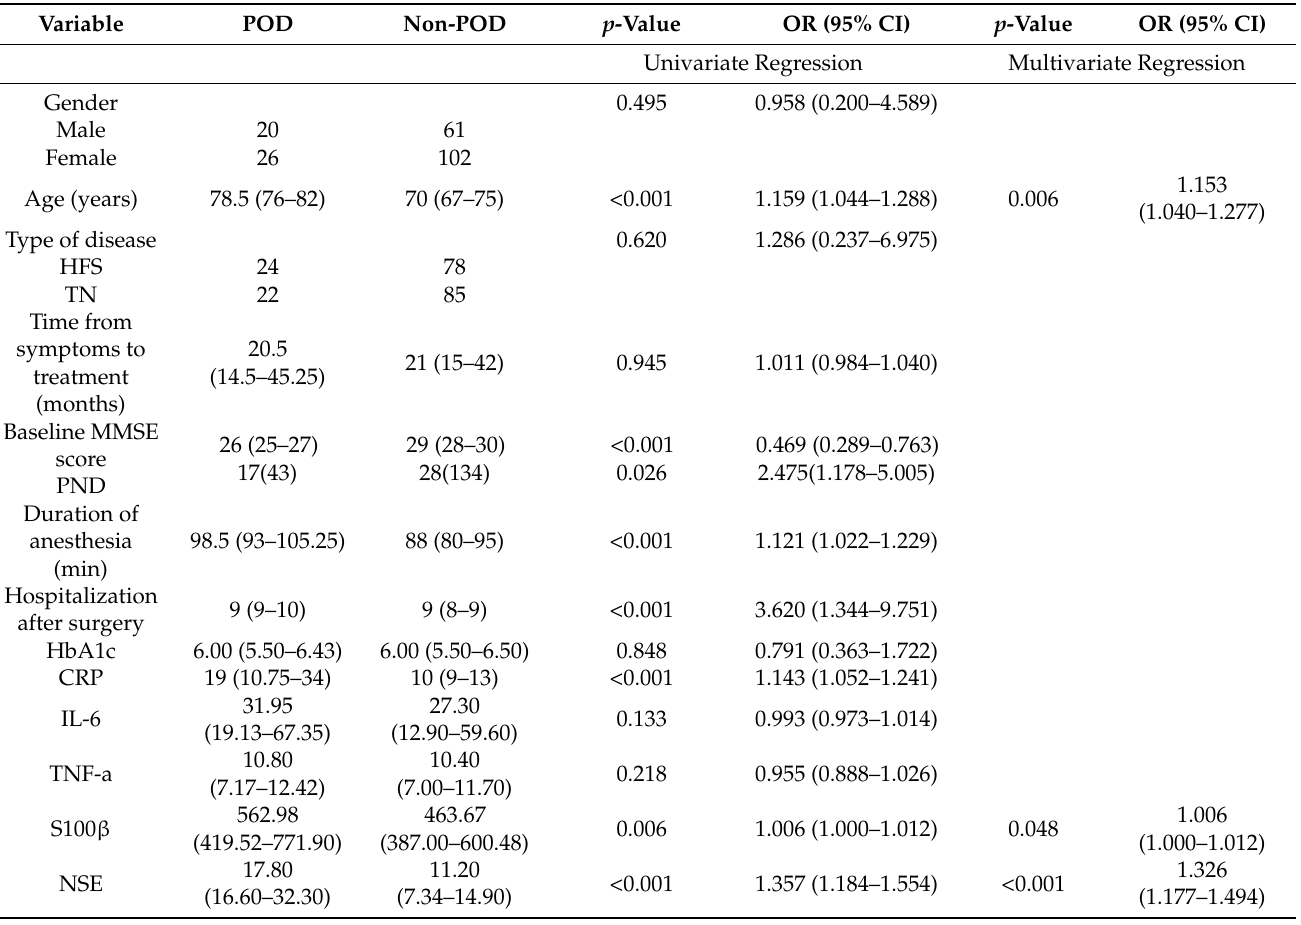
Table 2. Factors related to POD after MVD in older